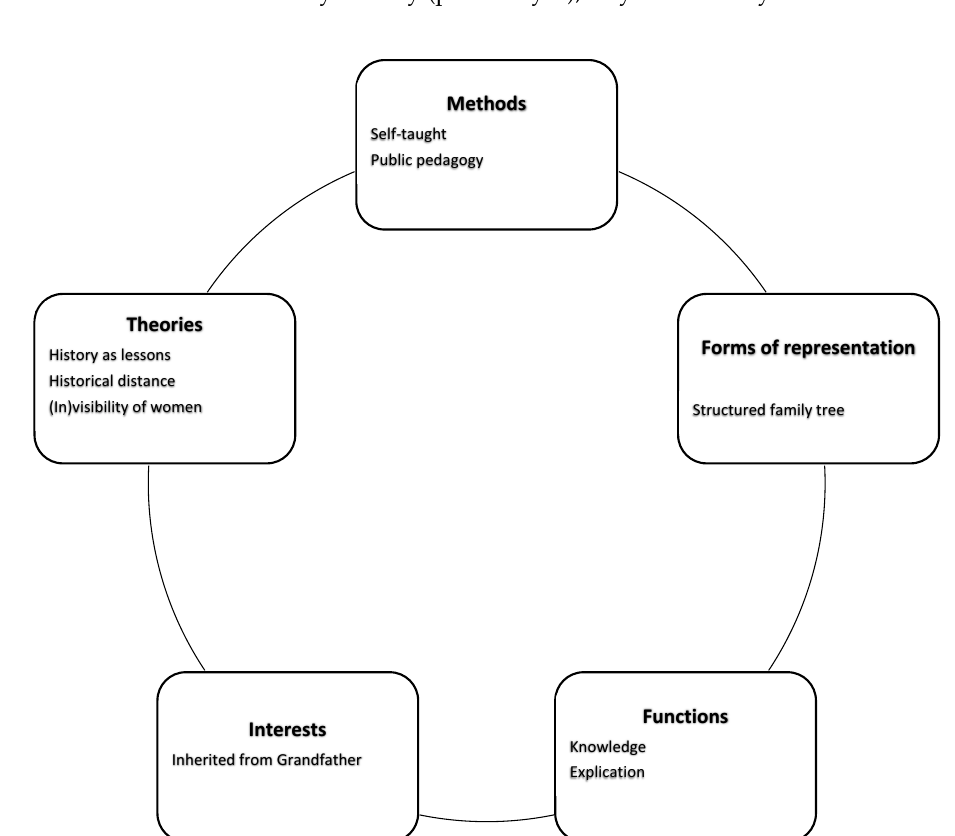
Figure 4. Case study three in alignment with Rüsen’s (1993) Disciplinary Matrix.